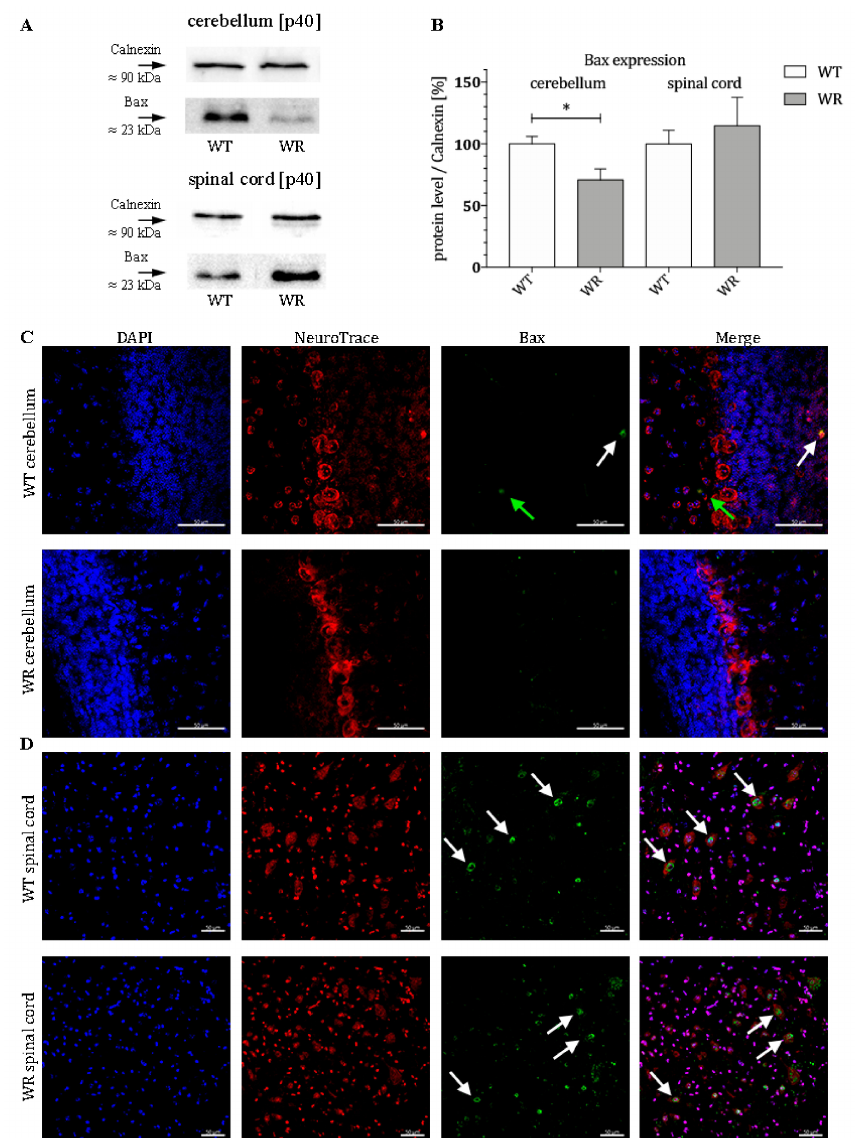
Figure 2. Di ff erential expression of Bax in cerebellum and spinal cord of wildtype and wobbler mice. ( A ). Exemplary Western blot of Bax protein expression levels in WT and WR cerebellum and spinal cord at stable symptomatic stage p40. Calnexin was used as control protein. Intensity values of Bax were normalized to calnexin and compared to WT tissue. ( B ). Quantitative analysis of Bax protein expression level in the cerebellum and cervical spinal cord from stable symptomatic phase of WT and WR mice. A significant downregulation was found in developmental stages p40 in the cerebellum, while there is no significant deregulation in the spinal cord. Data are provided as means ± SEM. Data were tested for significance using Student’s t-test. Significant di ff erences are indicated by * p < 0.05. n = 6. ( C ). Exemplary immunofluorescence staining of NeuroTrace, as Nissl marker (red), and Bax (green). Scattered staining of Bax could be detected within the granular (white arrow) and molecular (green arrow) layer of the cerebellar slices of WT mice at p40. ( D ). Exemplary immunofluorescence staining of NeuroTrace, as Nissl marker (red), and Bax (green). Specific staining for Bax was found to be located in NeuroTrace positive cells with a large cell body and nucleus, that can be assigned to be motor neuronal cells (white arrows). Nuclei were stained with DAPI (blue). Pictures were taken using a confocal laser scanning microscope (LSM 800, Zeiss, Germany with a 40 × objective (PlanApo 40 × / 1.4 Oil DICII, Nikon instruments). Scale bar = 50 µ